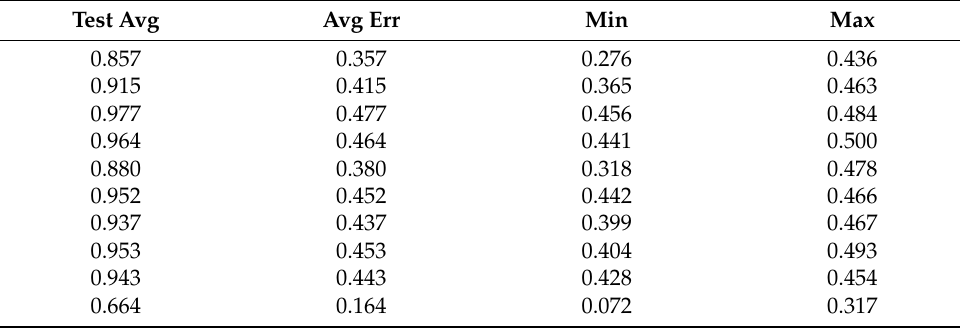
Table A178. Set 3, trials 11–20 data (all 0.5 PR